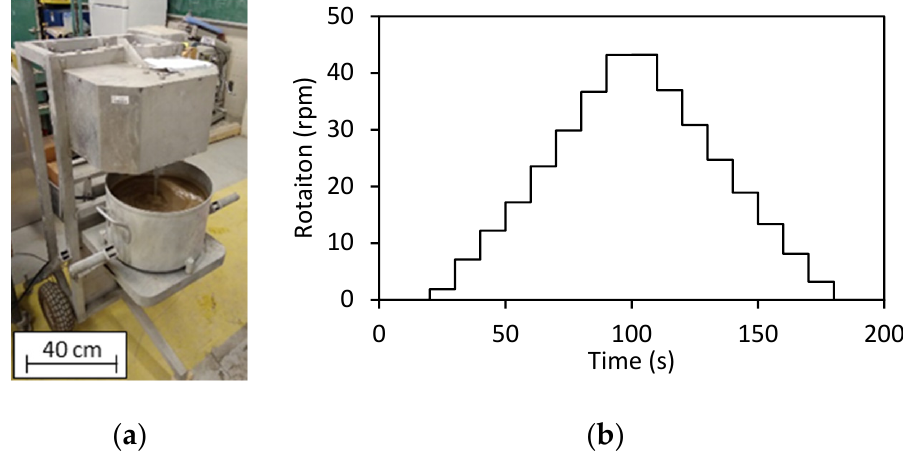
Figure 4. ( a ) IBB rheometer and ( b ) test programme used for analyzing the rheology cycle.